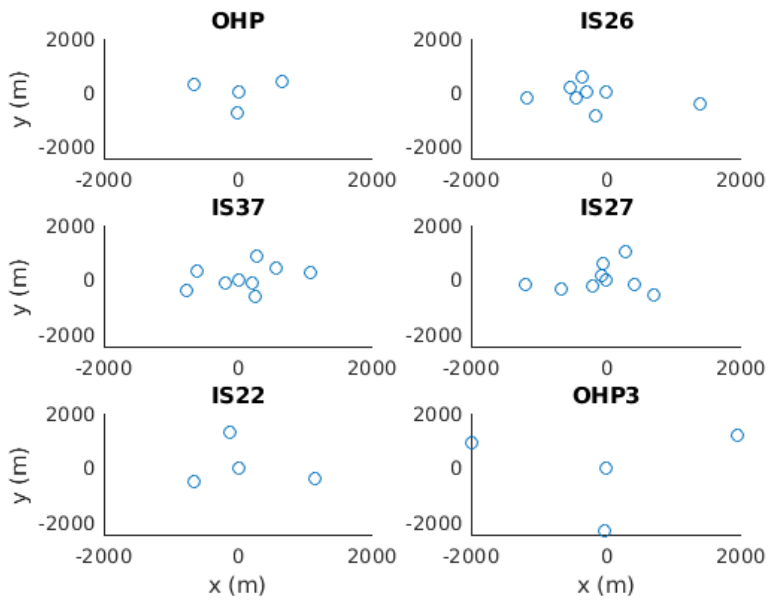
Figure 9. Plots of the six array geometries used in this study.